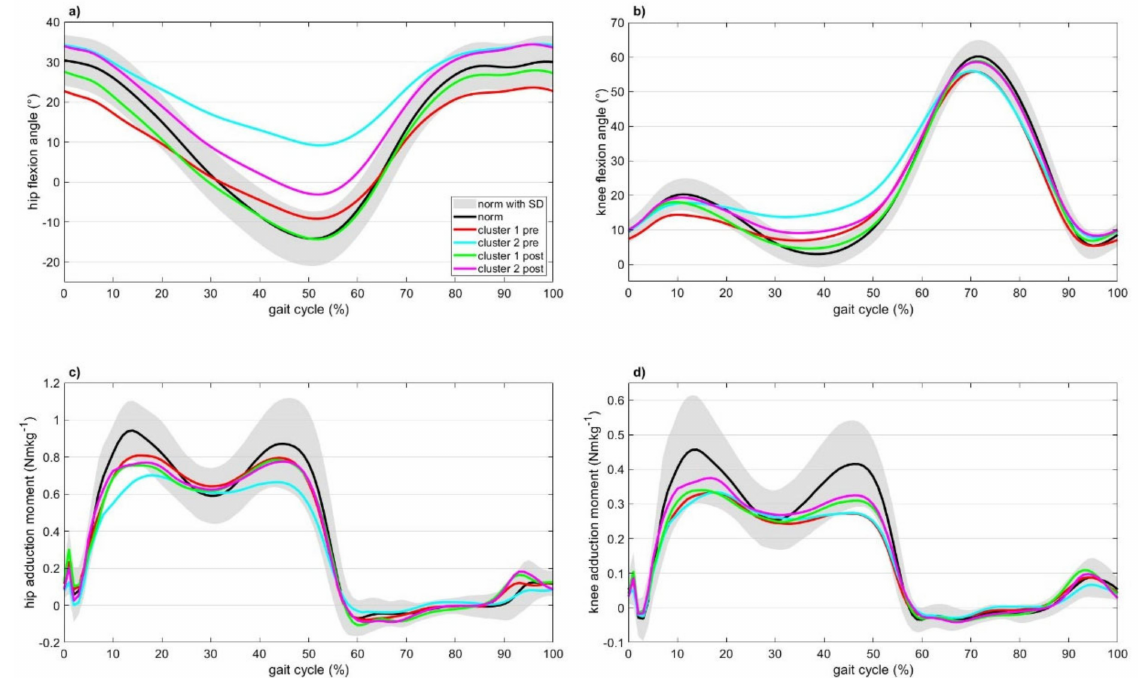
Figure 1. For both clusters and in relation to the healthy controls the preoperative and postoperative ( a ) hip flex- ion/extension, ( b ) knee flexion/extension, ( c ) external hip adduction moment and ( d ) external knee adduction moment are displayed. Data